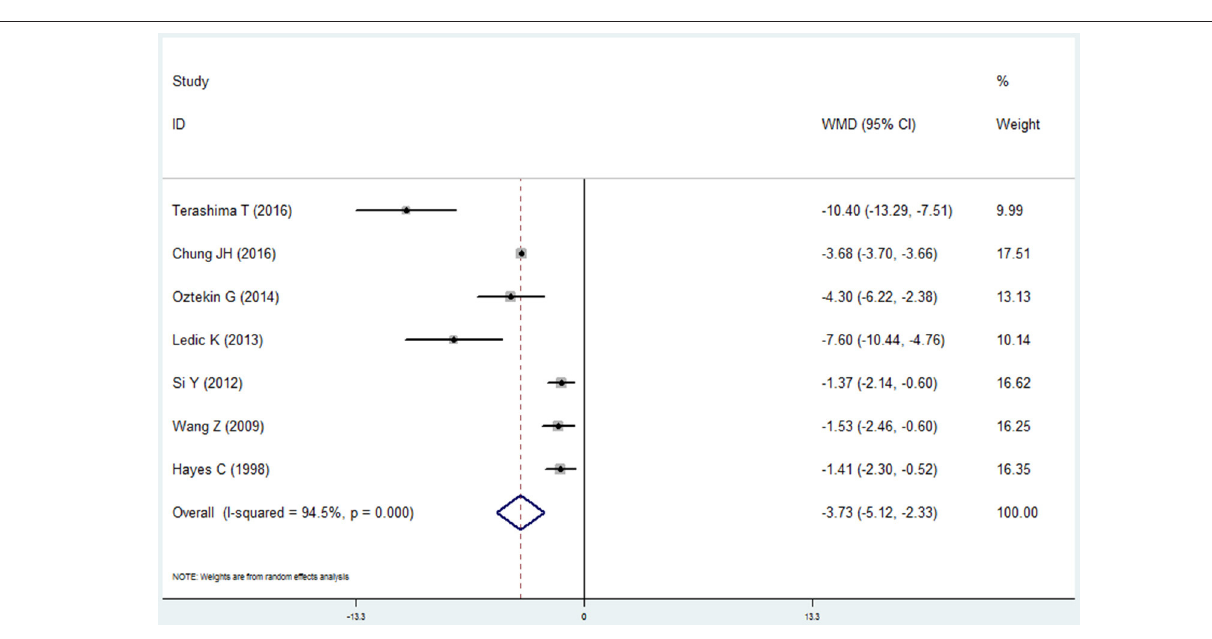
FIGURE 10 | Forest plot of the mean difference in remaining teeth between the COPD and non-COPD